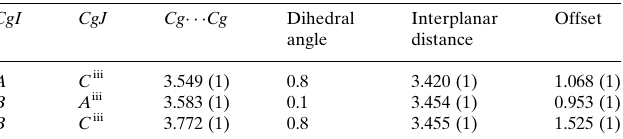
Table 2 (cid:2) – (cid:2) interactions (A˚ , (cid:2)